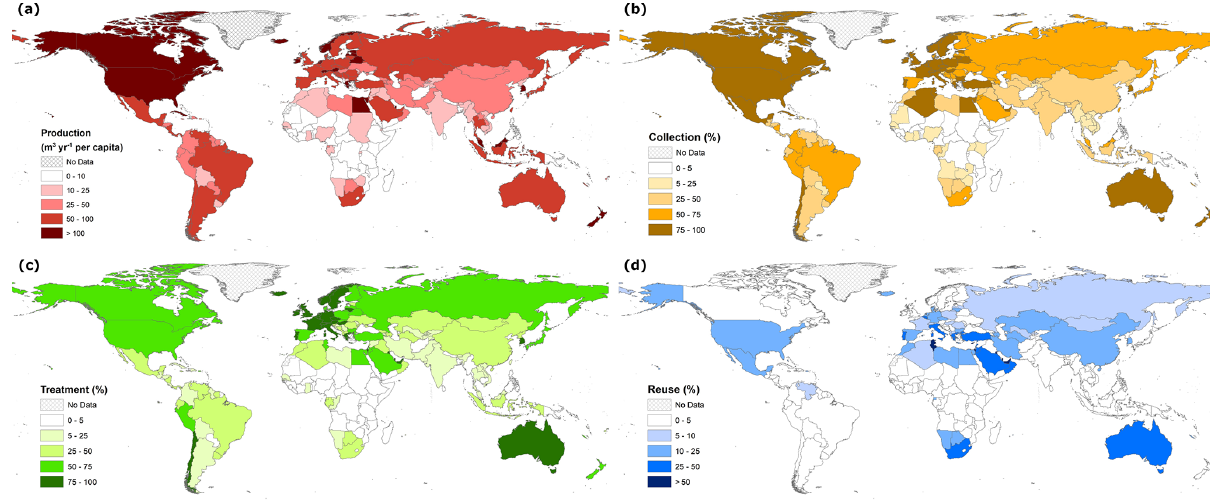
Figure 3. Wastewater production (m 3 yr − 1 per capita) (a) , collection (%) (b) , treatment (%) (c) and reuse (%) (d) at the country scale.